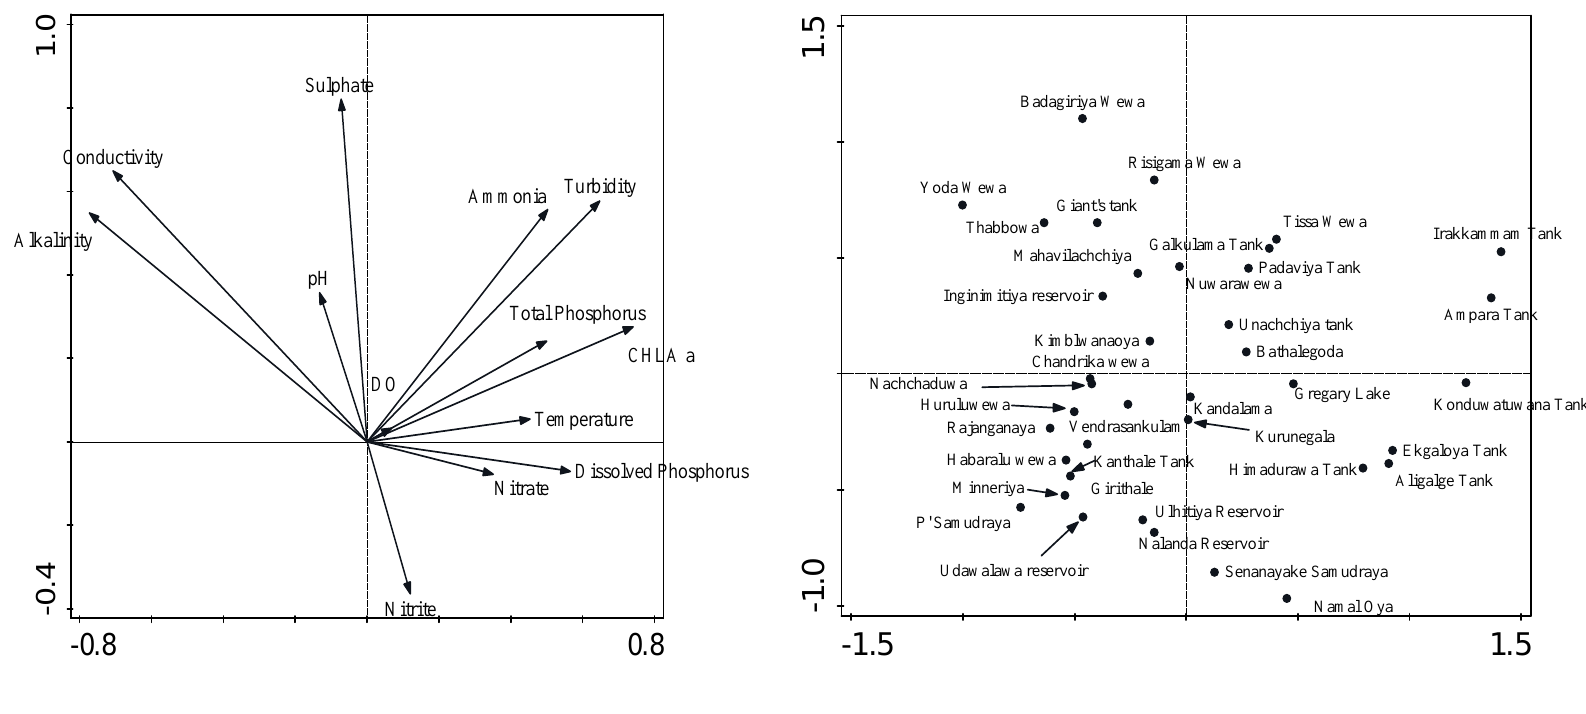
Figure 4 : Principal Components Analysis (PCA) ordination diagram of the 38 study sites and associated environmental variables during the wet season (a=distribution of environmental variable; b=distribution of